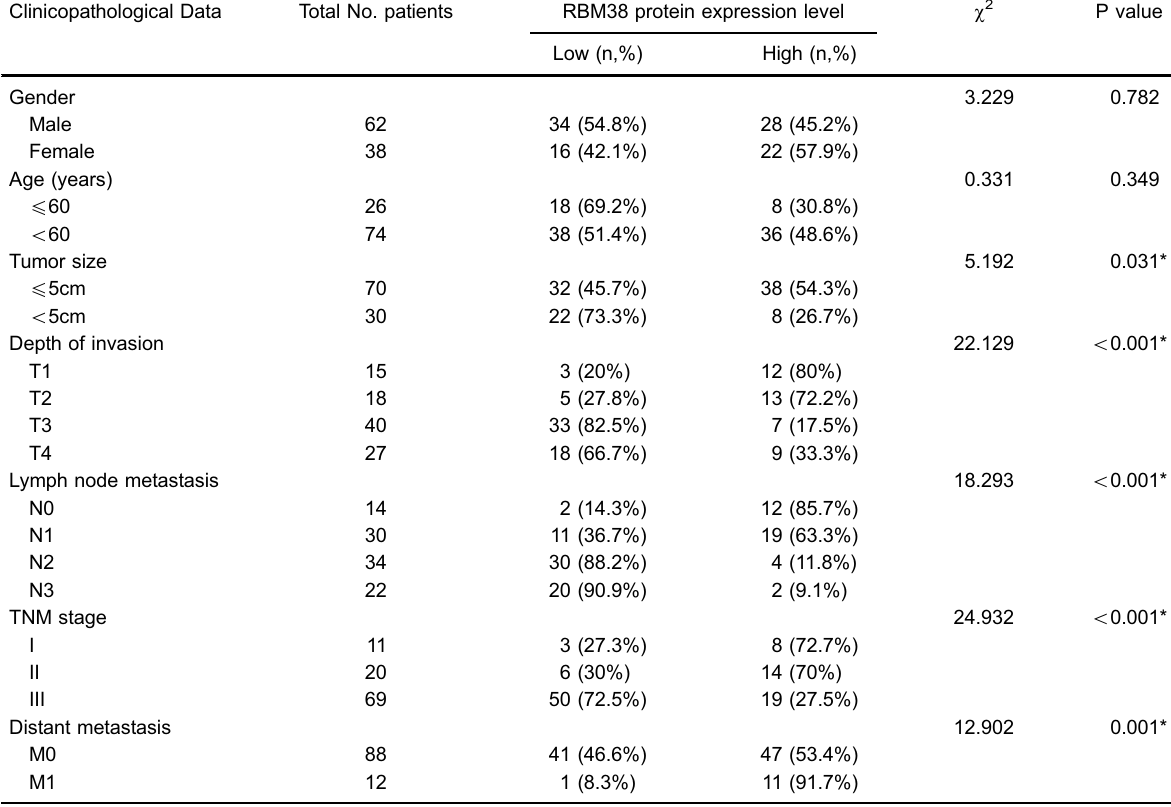
Table 1. Correlation of RBM8A protein expression level with clinicopathological features in patients with gastric cancer